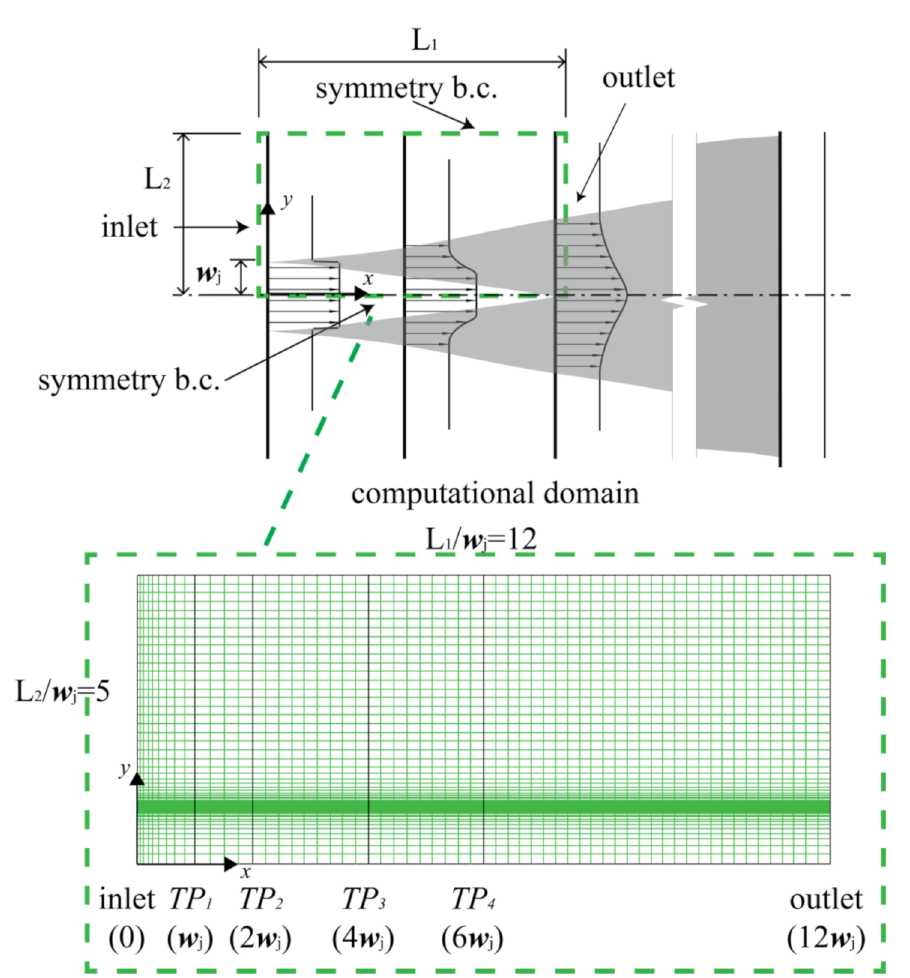
Figure 4. A jet flow ( top ) and the definition of the computational domain ( bottom ) [19].